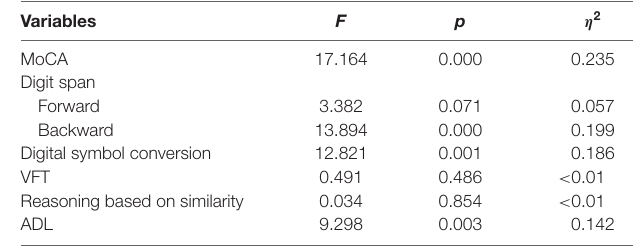
TABLE 2D | ANCOVA data between cognitive training group and controlled group in T3.